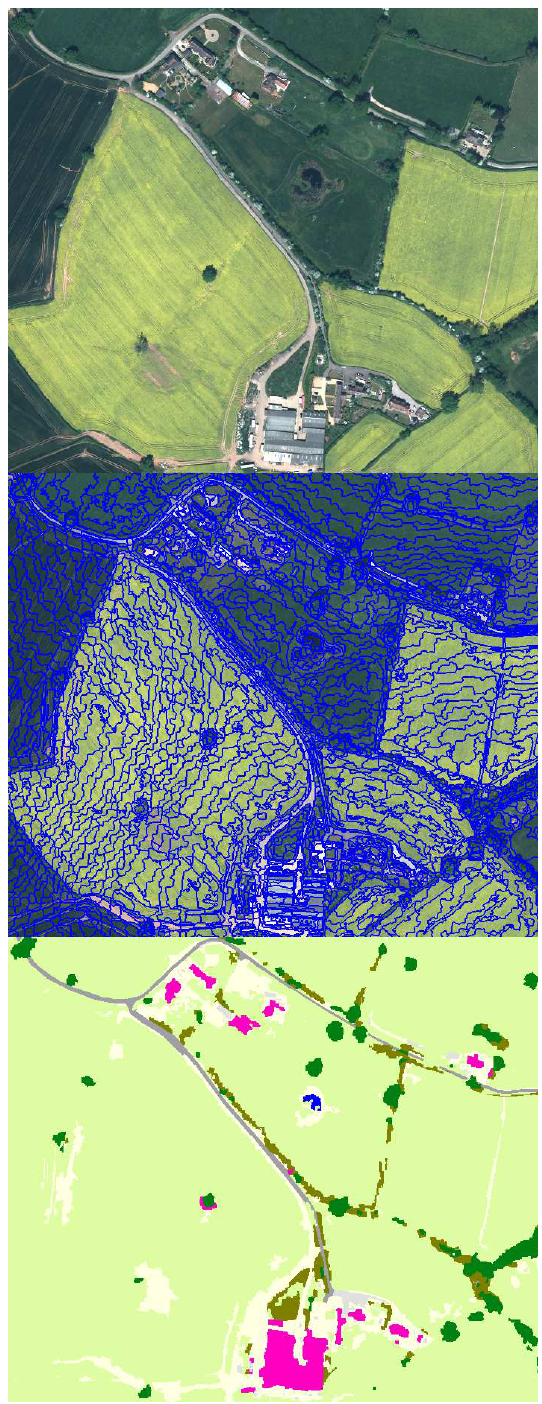
Figure 1. a) An image of a rural area, b) the corresponding segmentation in eCognition, and c) the final classification. Buildings are in pink, grassland in pale green, sealed surface in light grey, roads in dark grey, trees in dark green, water in blue and scrub in olive